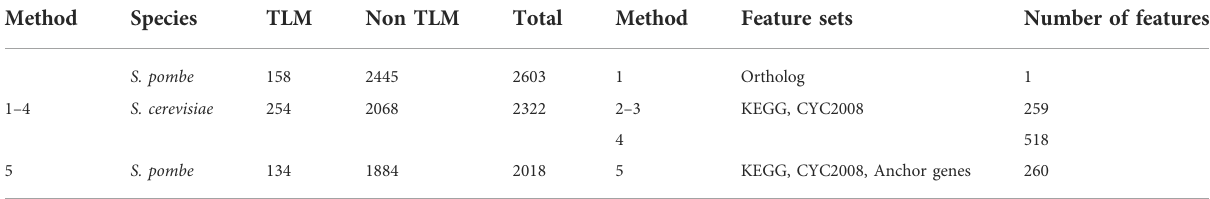
TABLE 3 Overview of datasets used in different methods for classifying TLM and non TLM genes.